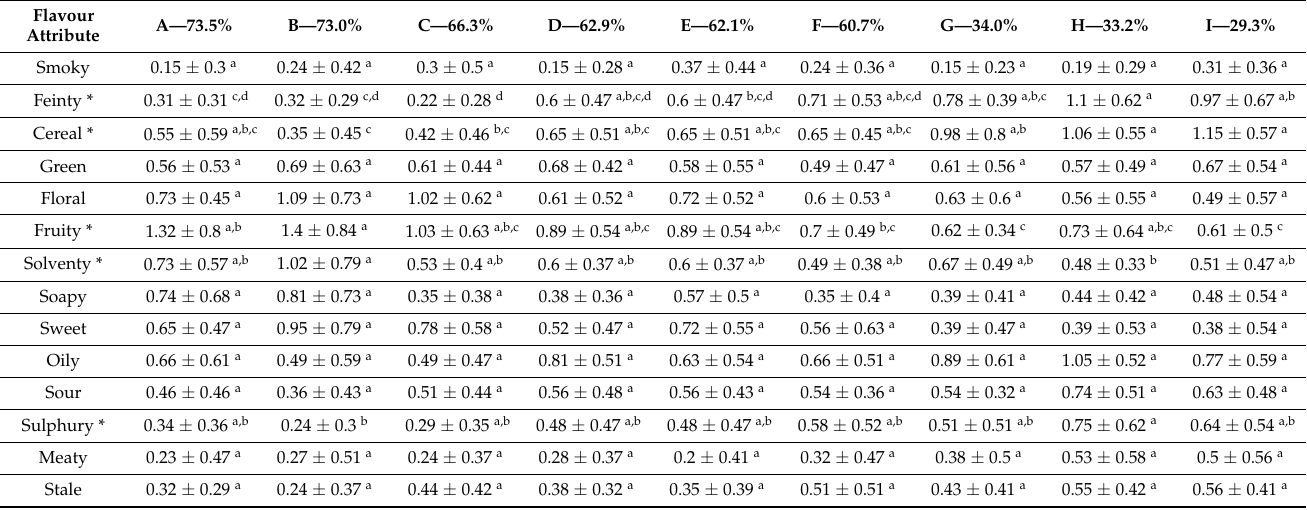
Table A1. Results from the QDA of nine new make spirits showing mean panel scores, standard deviations, and Tukey’s groupings (a,b,c,d). * displays significant differences ( p < 0.05).